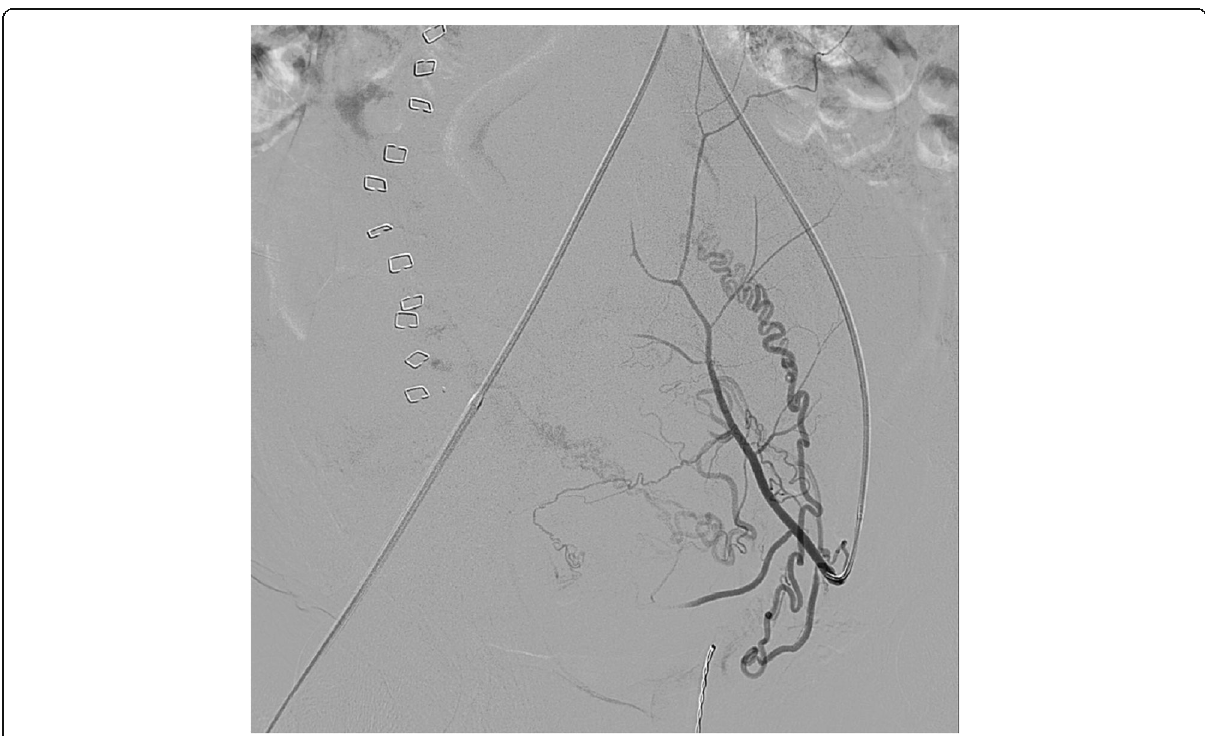
Fig. 3 Pelvic angiogram demonstrates prominent round ligament artery (arrows) arising from the inferior epigastric artery and contributing to a case of severe PPH that was subsequently